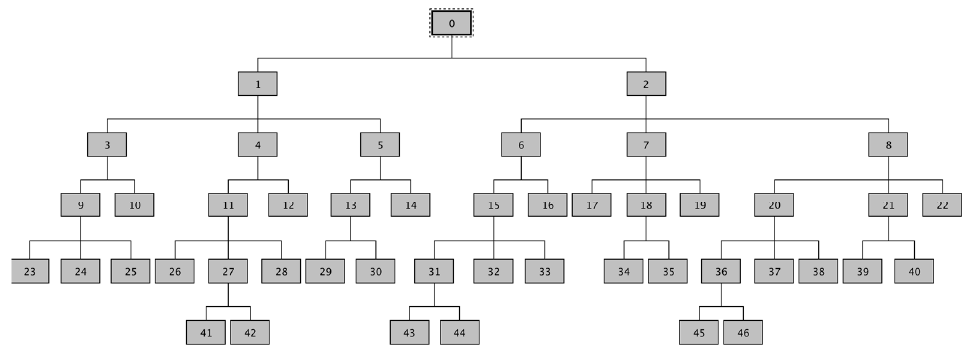
Figure 1. Decision Tree (DT) Diagram.